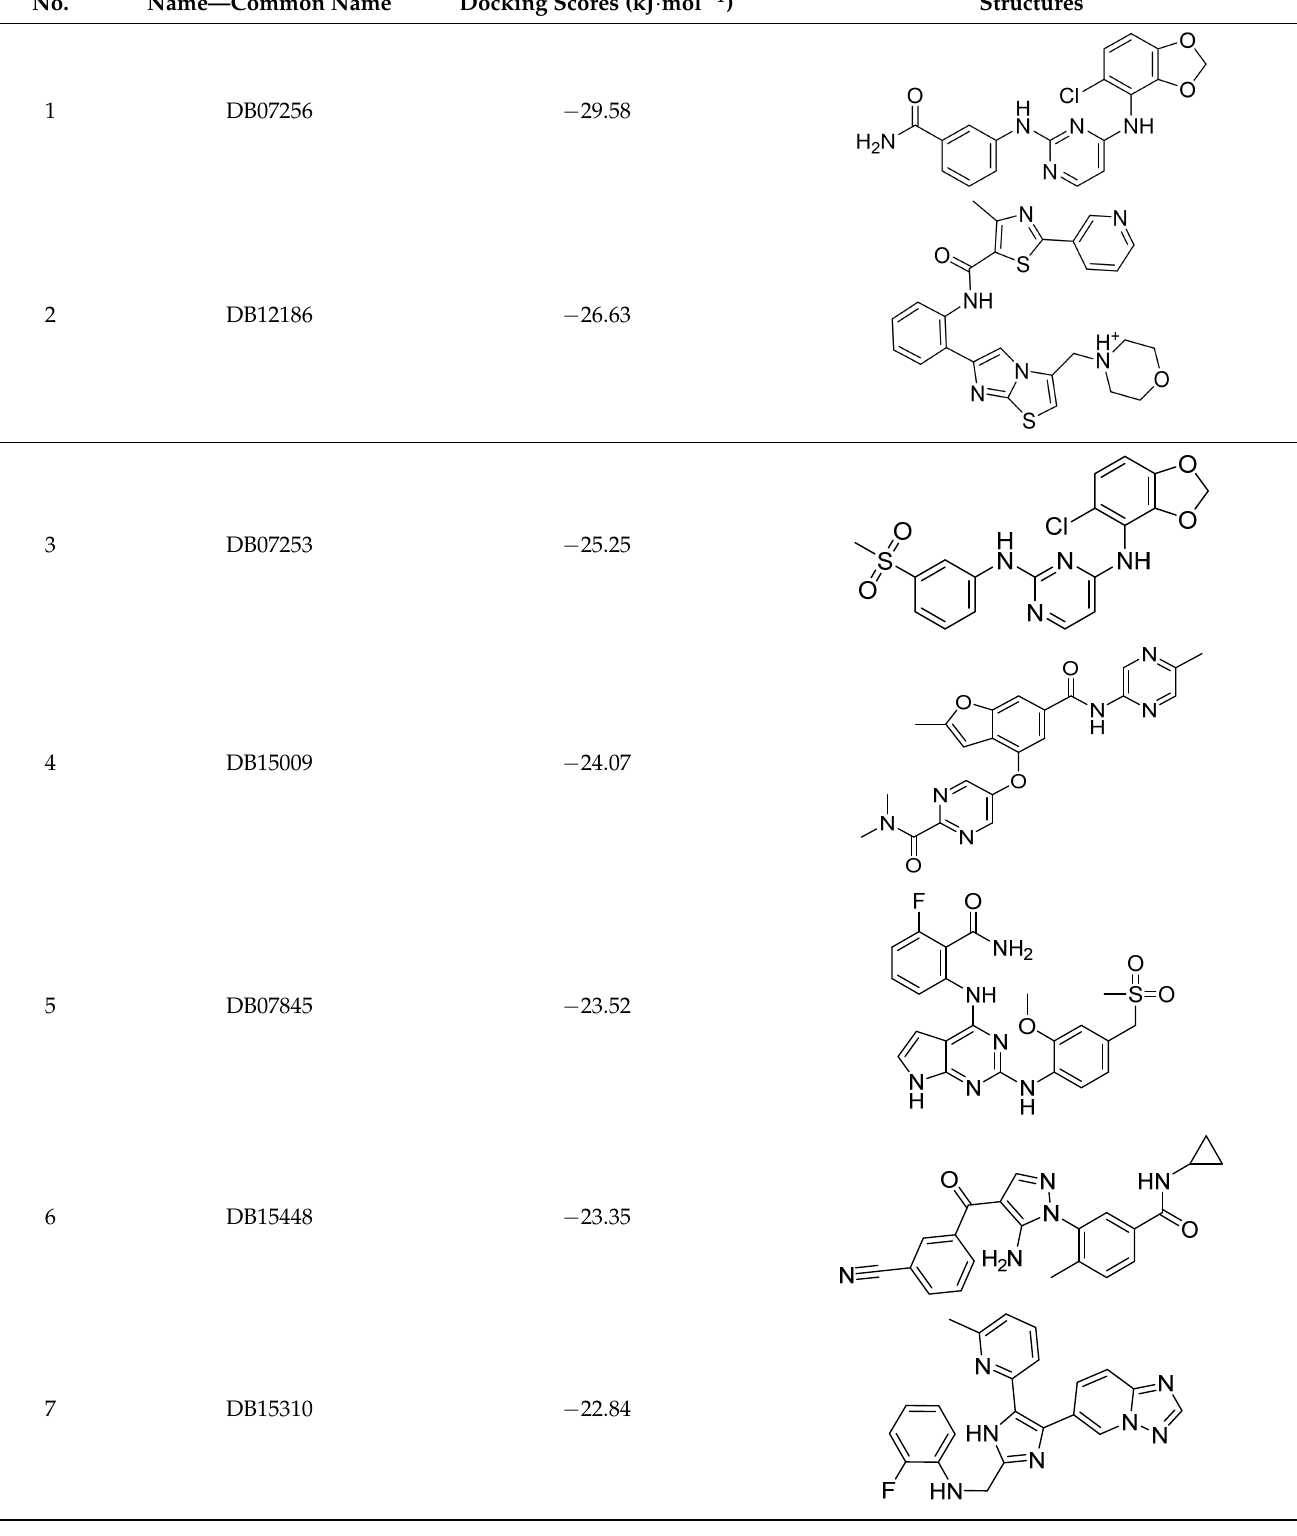
Table 8. Selected compounds with inhibitory potential for ABCG2 .